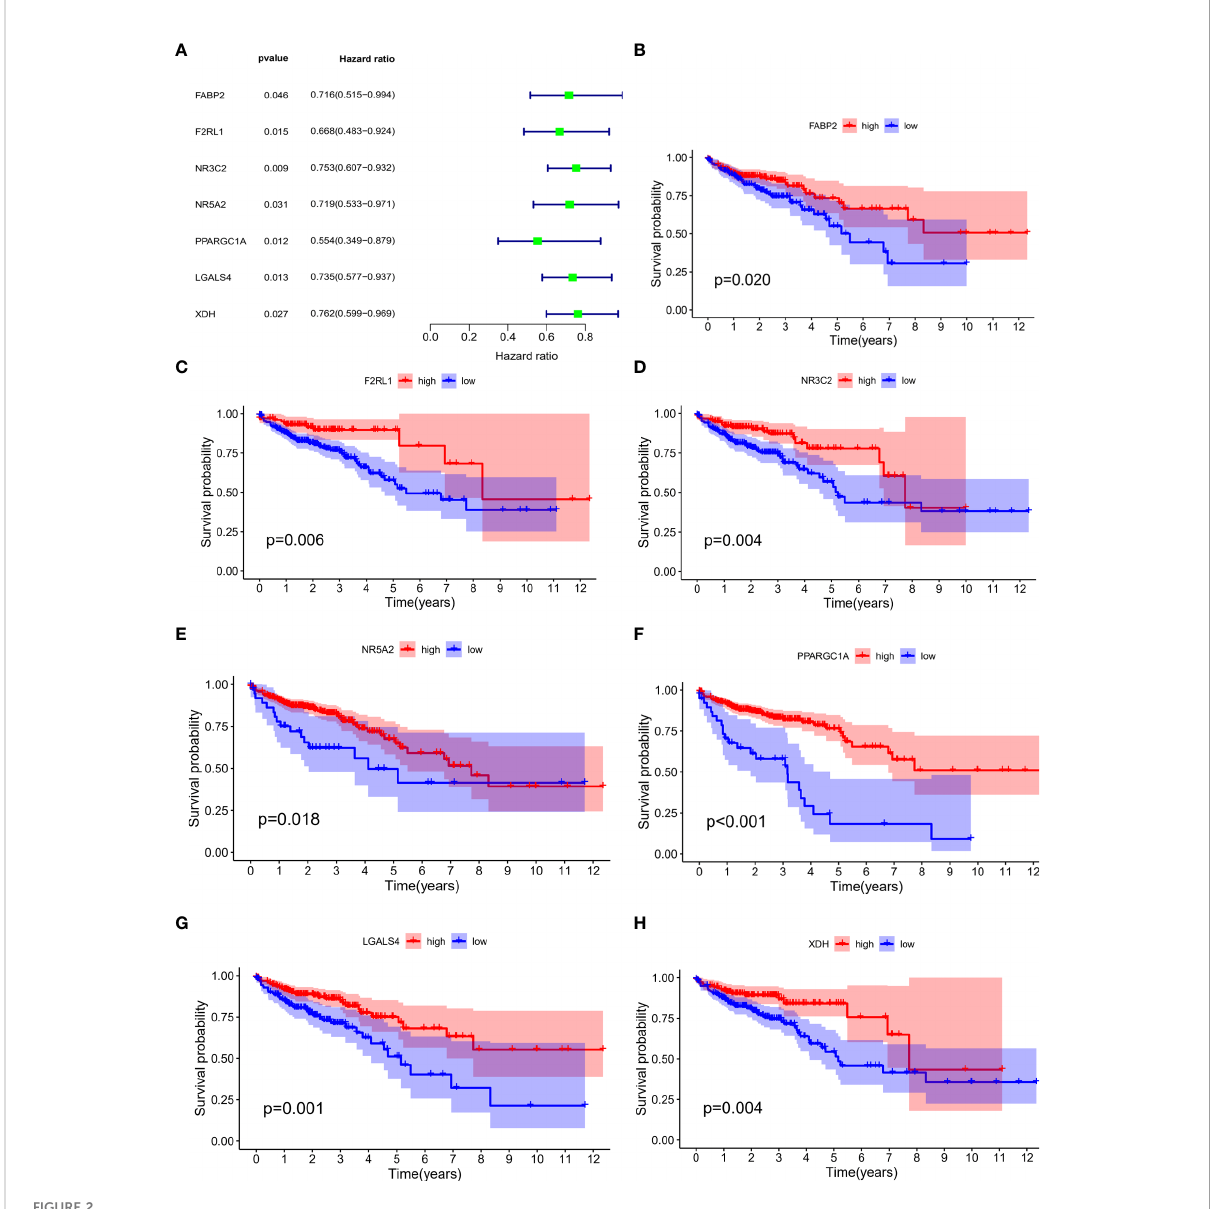
FIGURE 2 Univariate cox regression analysis was performed to identify survival-related IRGs. (A) FABP2, F2RL1, NR3C2, NR5A2, PPARGC1A, LGALS4 and XDH were identi fi ed as survival-related genes. Patients with high FABP2 (B) , F2RL1 (C) , NR3C2 (D) , NR5A2 (E) , PPARGC1A (F) , LGALS4 (G) and XDH (H) expression had better survival than patients with low expression of those